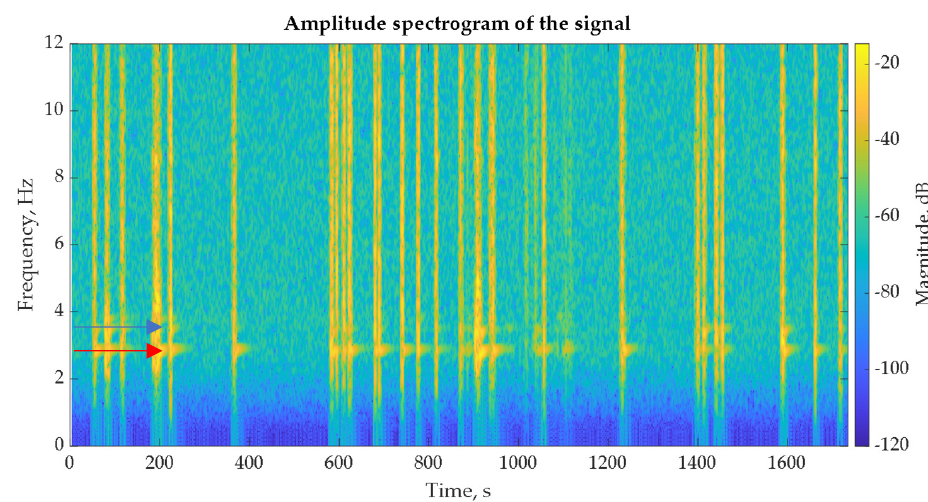
Figure 13. Short Time Fourier Spectrum of sensor 2 at vertical axis (Z axis).